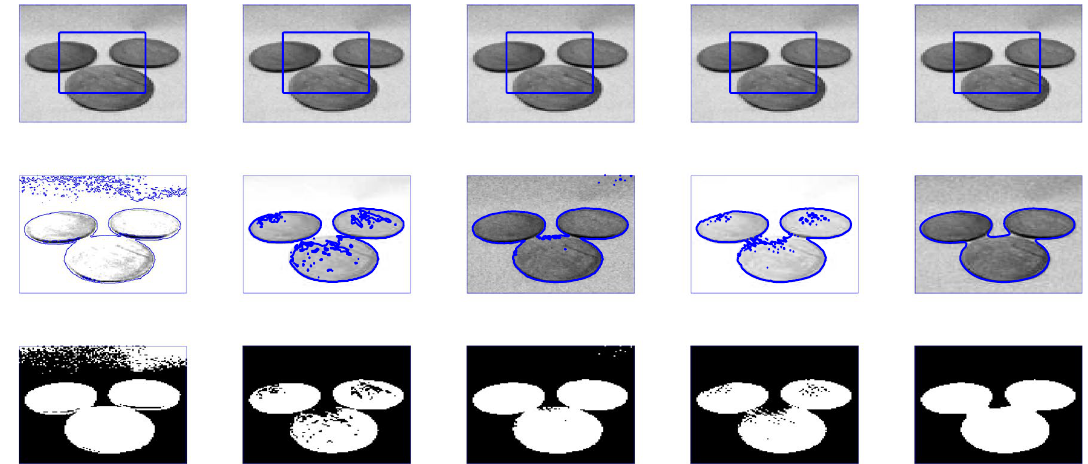
Figure 9. First, second, third and fourth columns are the segmentation results of Wu et al. 24 , Li et al. 15 , Wu et al. 12 and Krinidis et al. 31 , respectively. The fifth column is the segmentation result of proposed model with p = 0.5 , µ = 0.7, σ = 3, and speckle noise =